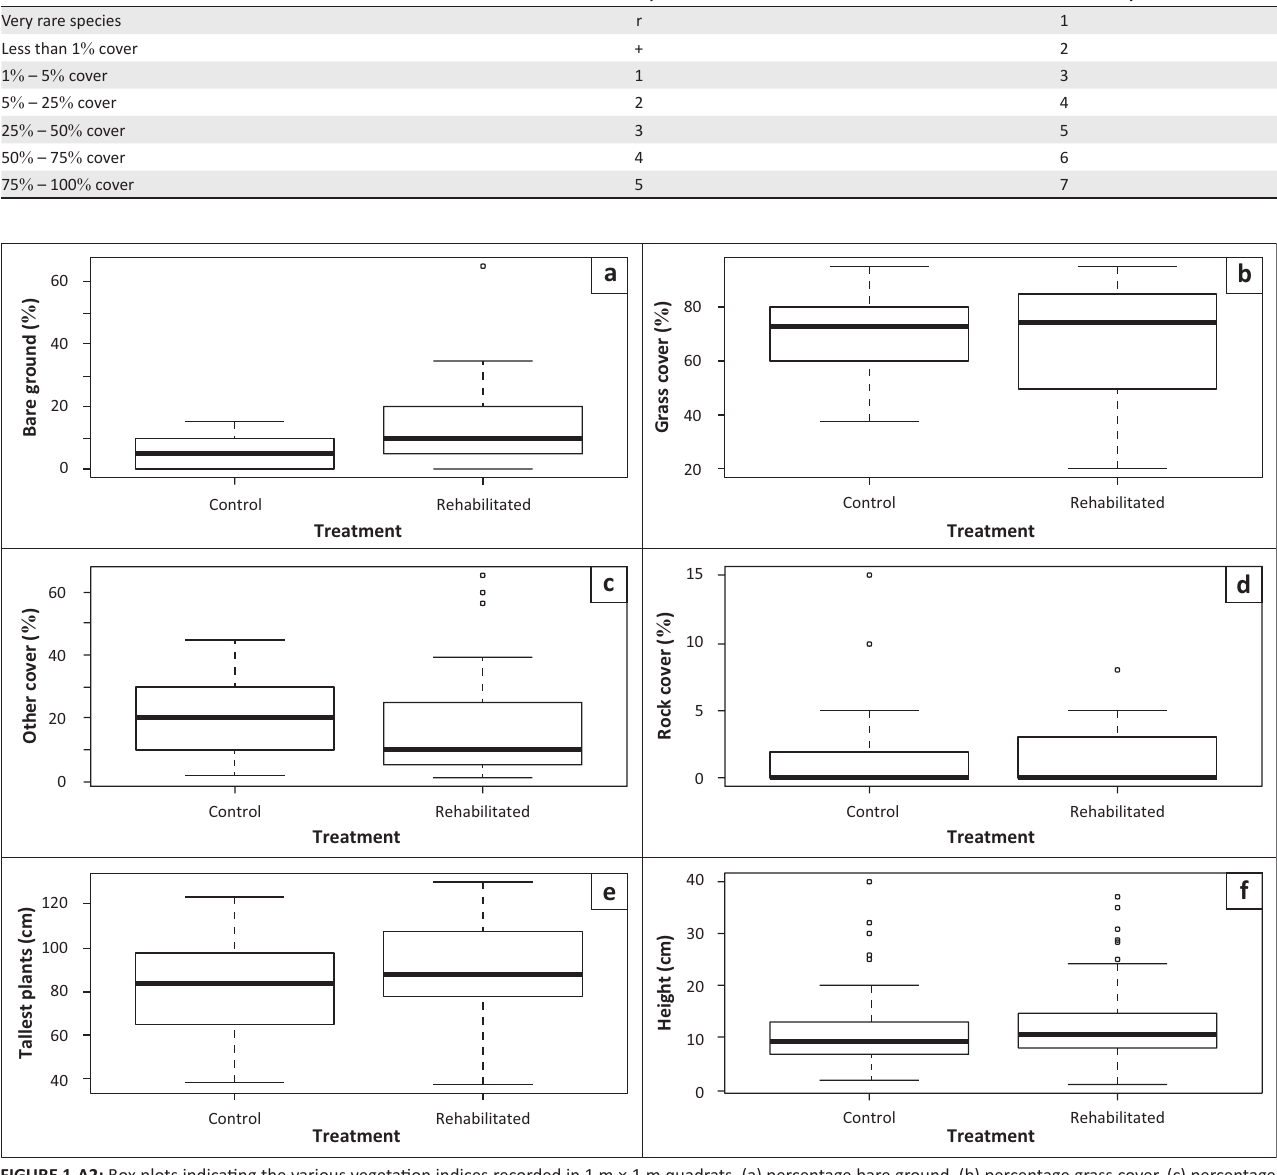
TABLE 1-A2: Plant morphospecies abundance quantified with the use of the Braun–Blanquet abundance scale and the altered scale that was used during the analysis of data. Cover or abundance